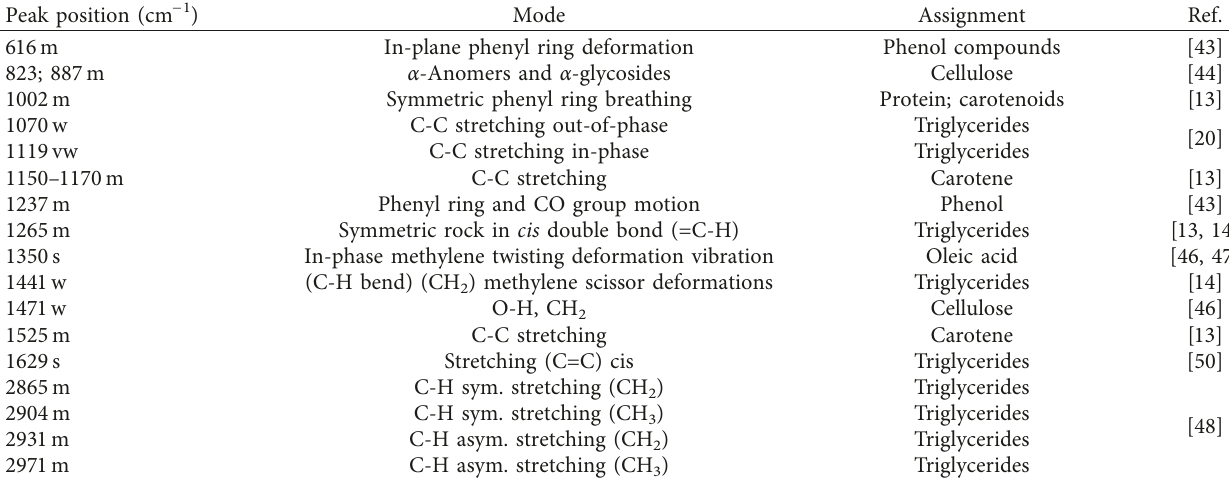
Figure 3: SERS spectrum of EVOO on a GNP seed/glass substrate after background signal subtraction. The main spectrum components are indicated in different colours. Table 1: Main Raman peaks observed in the spectra with assignments in accordance with the data reported in the literature. s, strong; m, medium; w, weak; vw, very